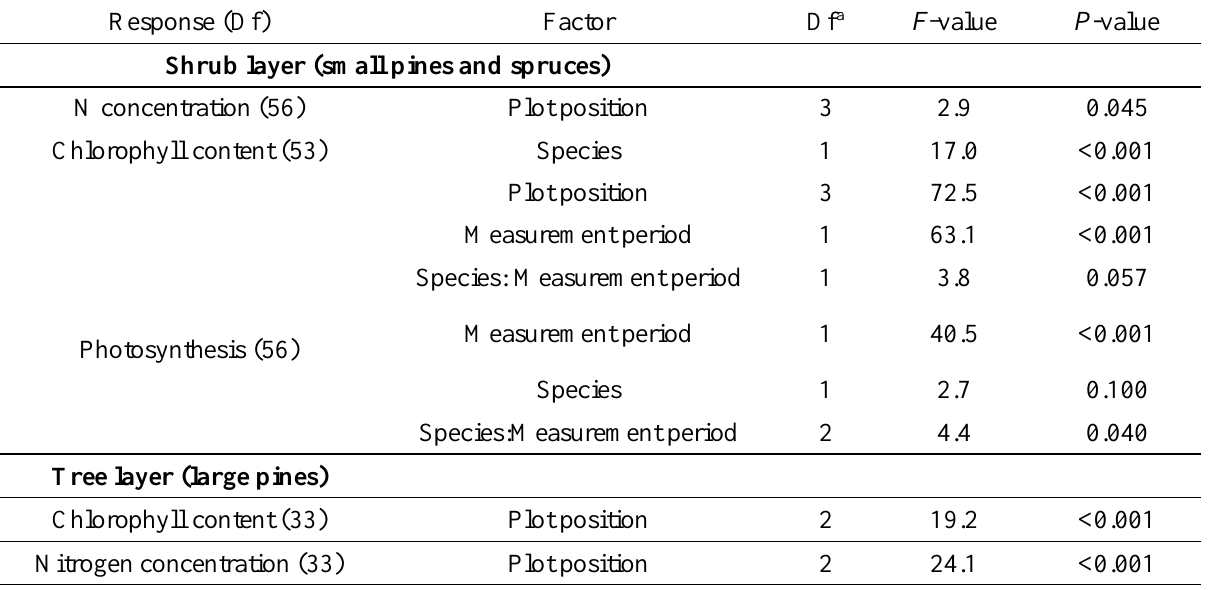
Figure 2. Nitrogen concentrations in Pinus rotundata (small and large pines) and Picea abies (spruce) needles in April and May 2014. No significant differences between the April and May measurement periods were found. Different letters indicate significant differences between the positions along the two transects. Table 1. Summary of ANOVA-results for the linear models used to test the effects of plot position, measurement period and species composition on nitrogen concentration, chlorophyll content and photosynthetic capacity of bog pine and Norway spruce. Separate models were run for the shrub layer (small pines and spruce) and the tree layer (large pines). Df = degrees of